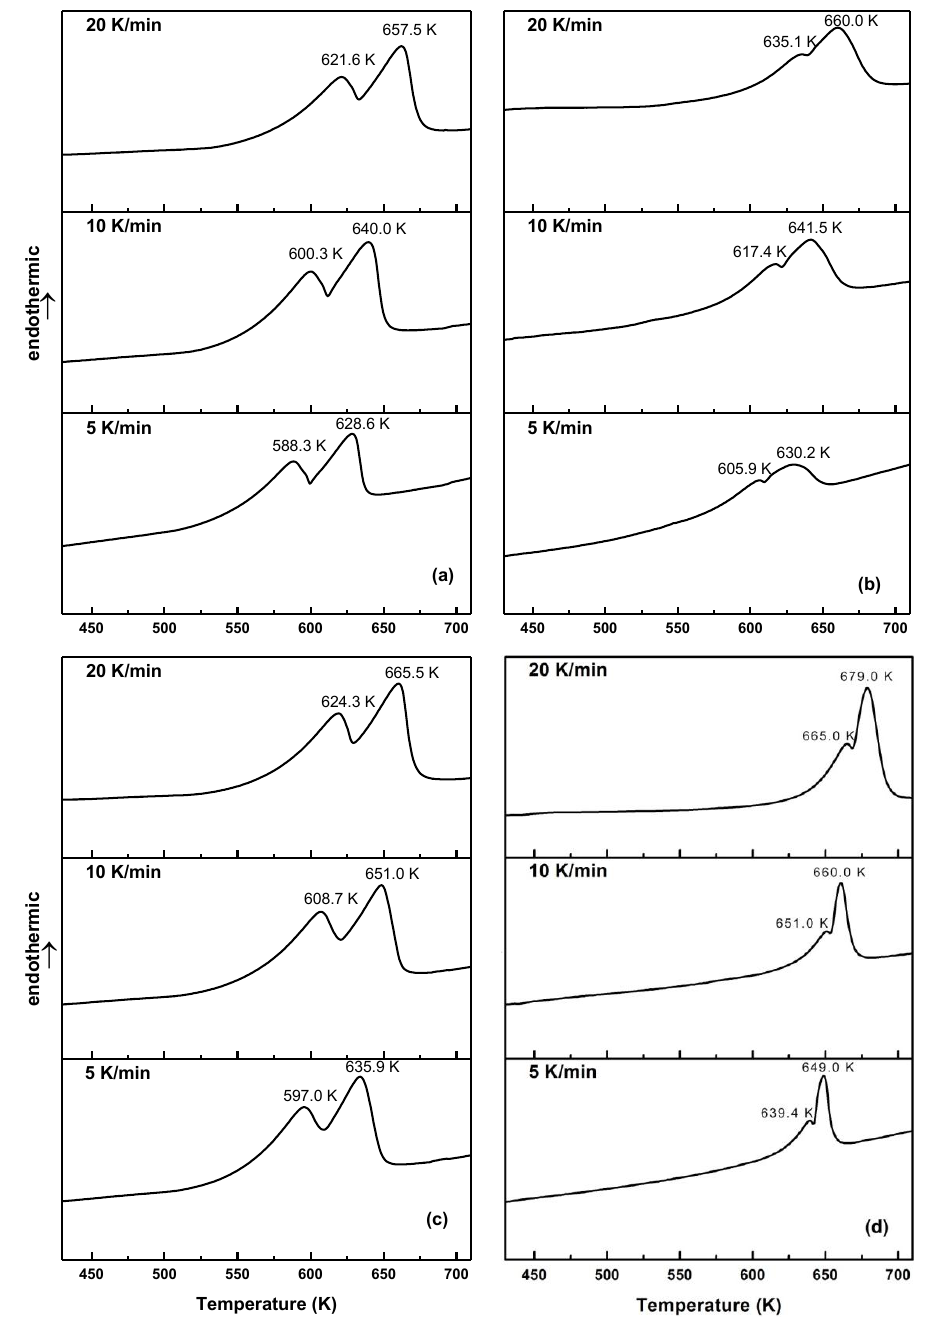
Figure 2. DSC curves of NaMgH 3 hydride and NH-CM composites at different heating rates. ( a ) NH–2.5M–2.5G; ( b ) NH–5G; ( c ) NH–5M; ( d ) NaMgH 3 hydride.